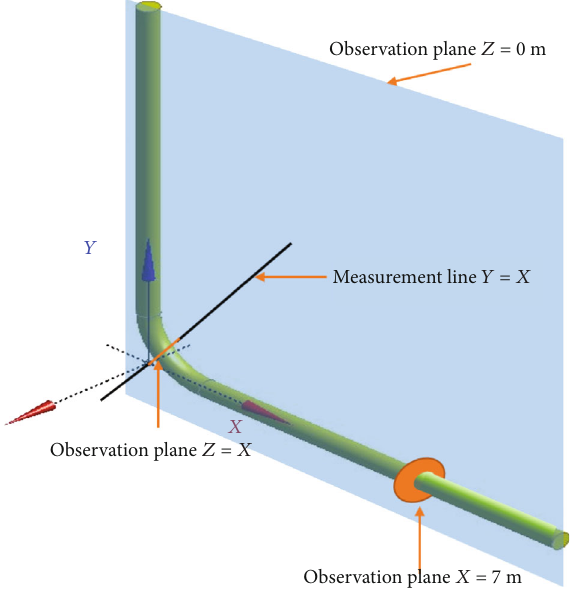
Figure 4: Geometry of the